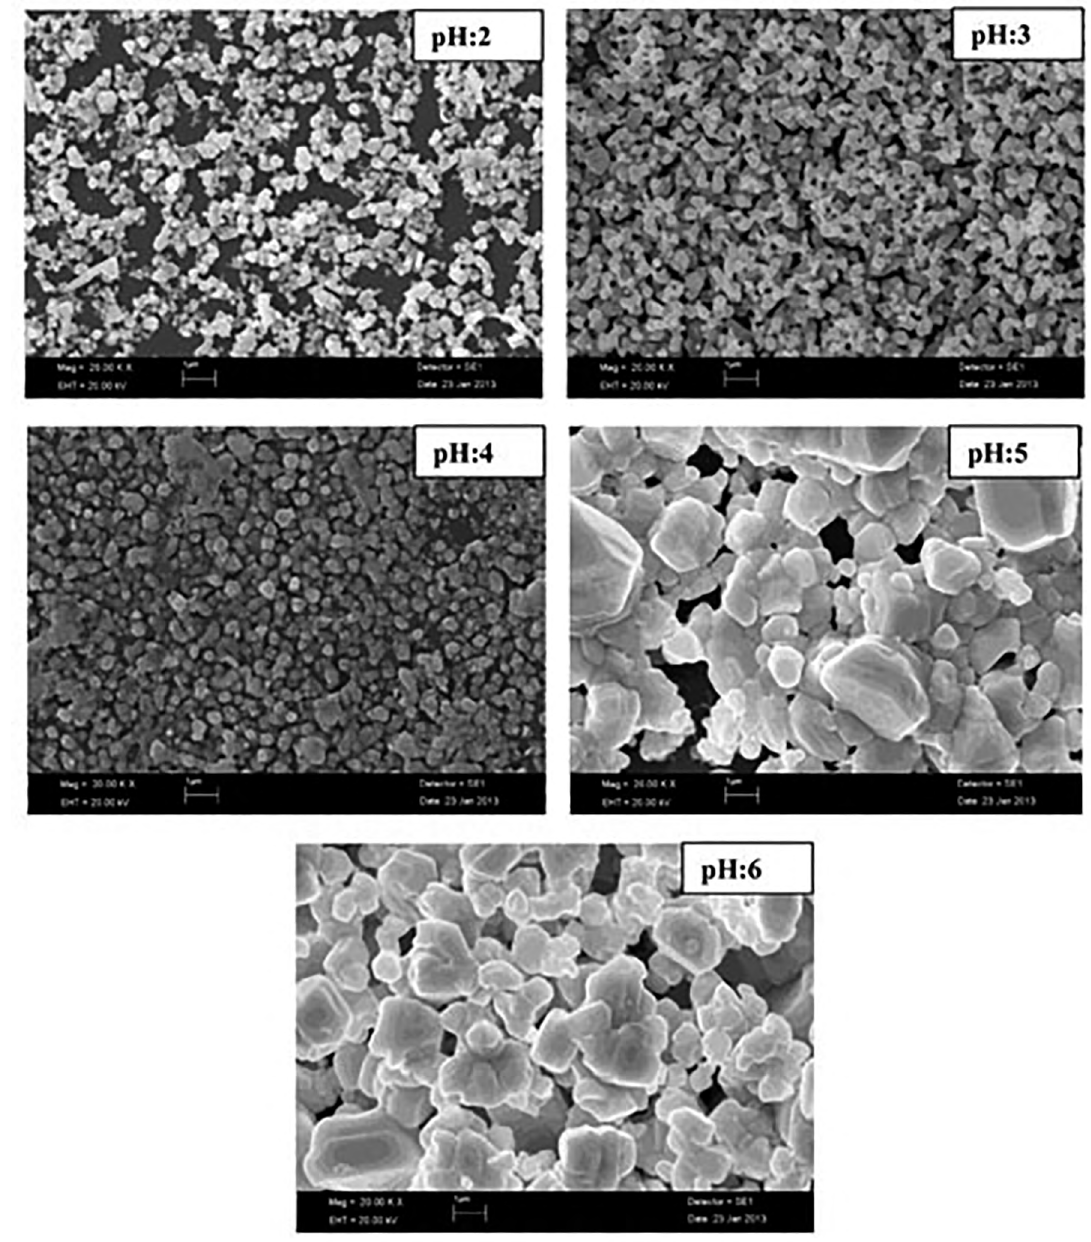
Figure 4. SEM imagines of AgI thin films.